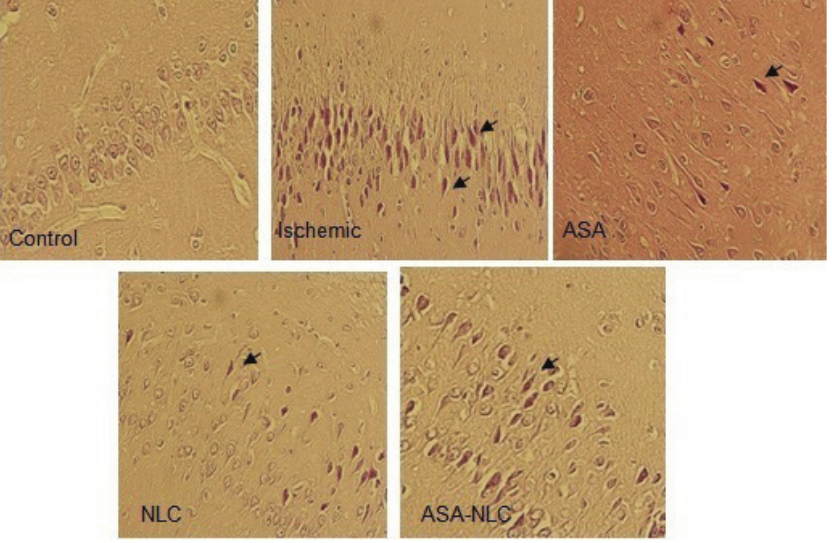
Figure 7: Slices of brain tissue stained by H&E. In the ischemic group, necrosis, foamy cytoplasm, shrunken neurons, and neuronal degeneration was observed. Magnification, ×200.